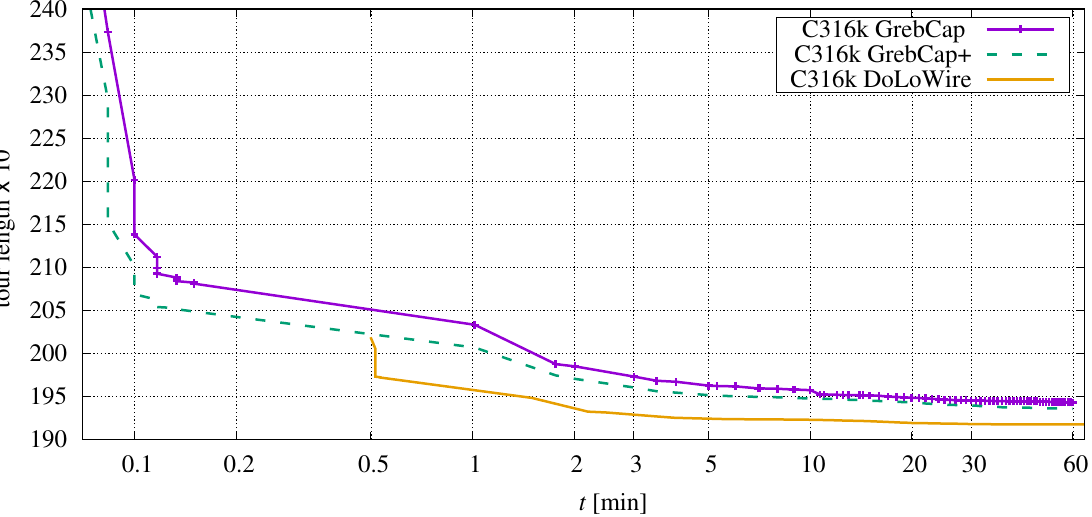
Figure 13. Comparison of tour length depending on elapsed time when using different initial-tour generators applied to